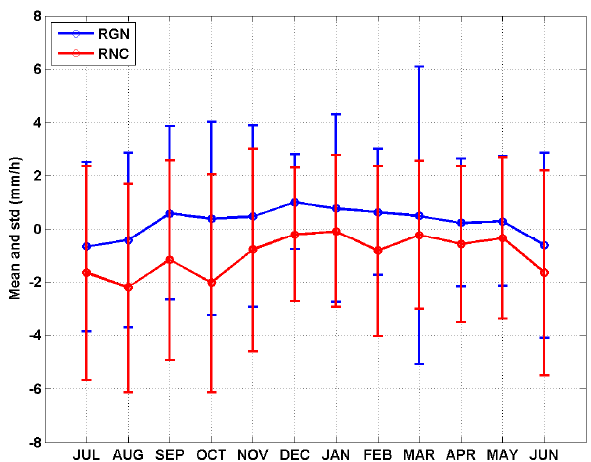
Fig. 12. Monthly mean difference (circles) and its standard devia- tion (error bars) of OPEMW sri product with respect to RGN (blue) Figure 12: Monthly mean difference (circles) and its standard deviation (error bars) of OPEMW sri 4 and RNC (red) products. Mean difference is computed as RGN (or product with respect to RGN (blue) and RNC (red) products. Mean difference is computed as RGN 5 RNC) minus (or RNC) minus OPEMW. 6